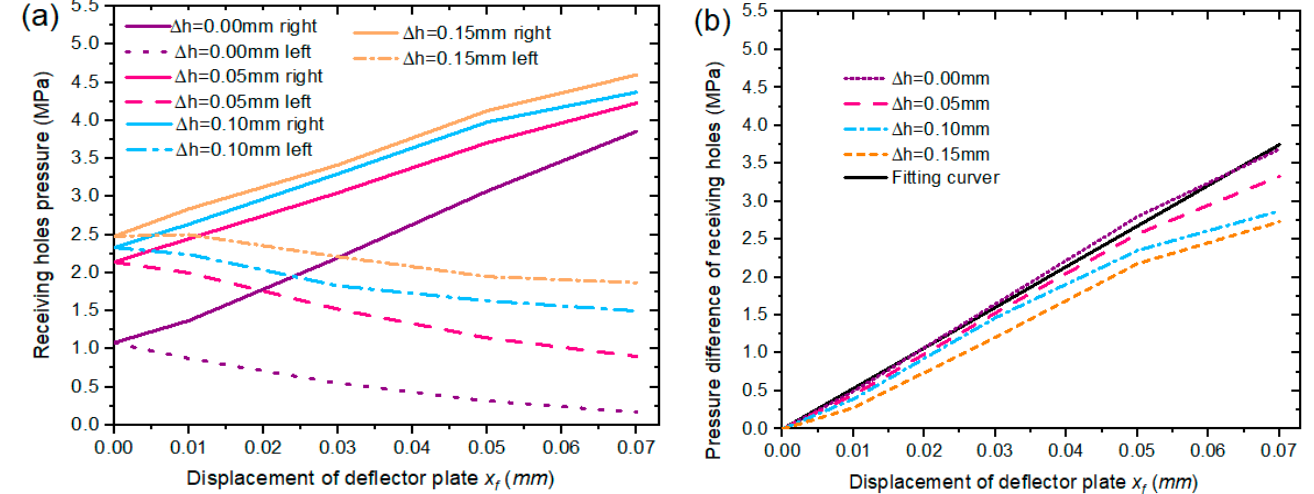
Figure 15. Pressures of two receiving holes before and after erosion ( a ), and pressure difference of two receiving holes ( b ).